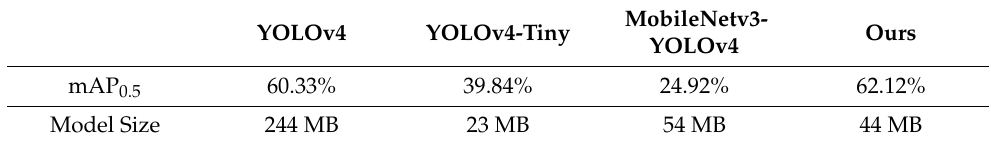
Table 7. Test results of self-made dataset.